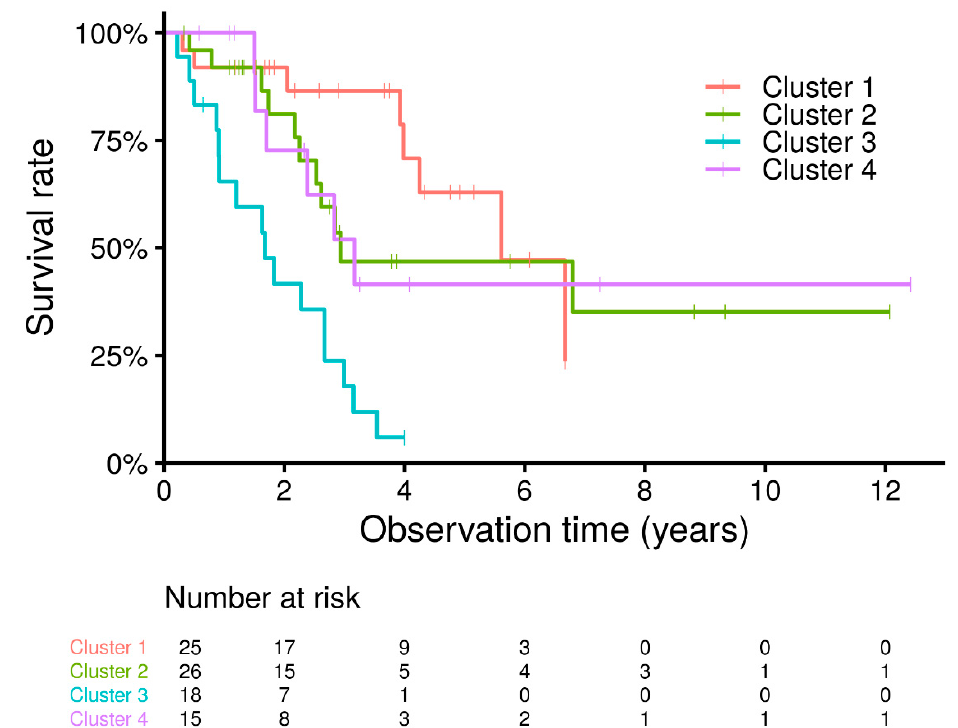
Figure 2. Kaplan–Meier survival curves according to idiopathic PPFE phenotypes. Survival of cluster 3 is significantly worse than that of the other clusters (cluster 3 vs. cluster 1, p < 0.001; vs. cluster 2, p = 0.0041; vs. cluster 4, p = 0.0155). No differences were found between clusters 1, 2, and 4 (cluster 1 vs. cluster 2, p = 0.4206; vs. cluster 4, p = 0.3515; cluster 2 vs. cluster 4, p = 0.9774).